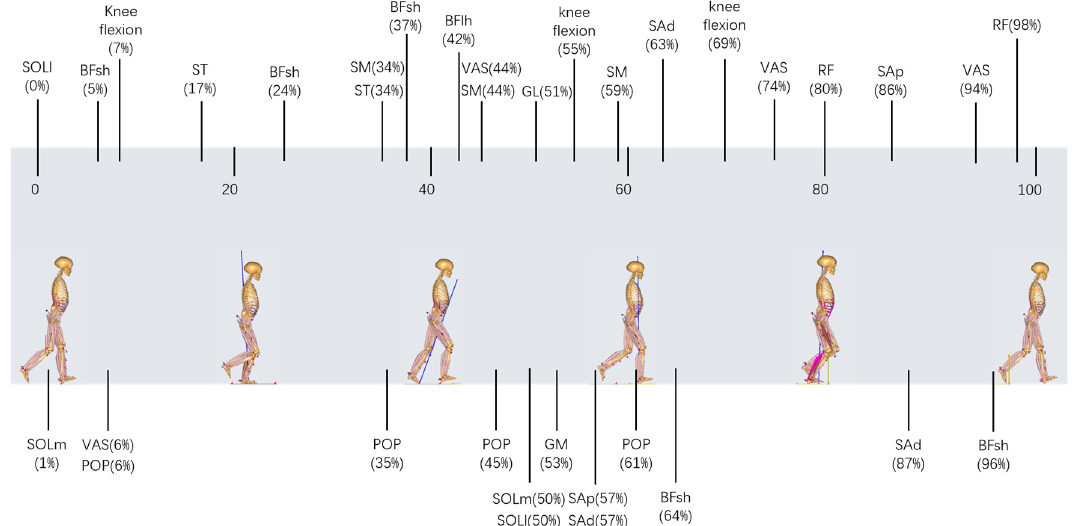
Figure 2. The filtered characteristic points, which were the time points in the gait cycle when the most significant difference ( p < 0.05 and p values were minimal) occurred between the ACLD and Control groups according to the two-sample t -test method. Characteristic points are shown at their corresponding points during the 0–100% gait cycle. ACLD, anterior cruciate ligament deficiency.